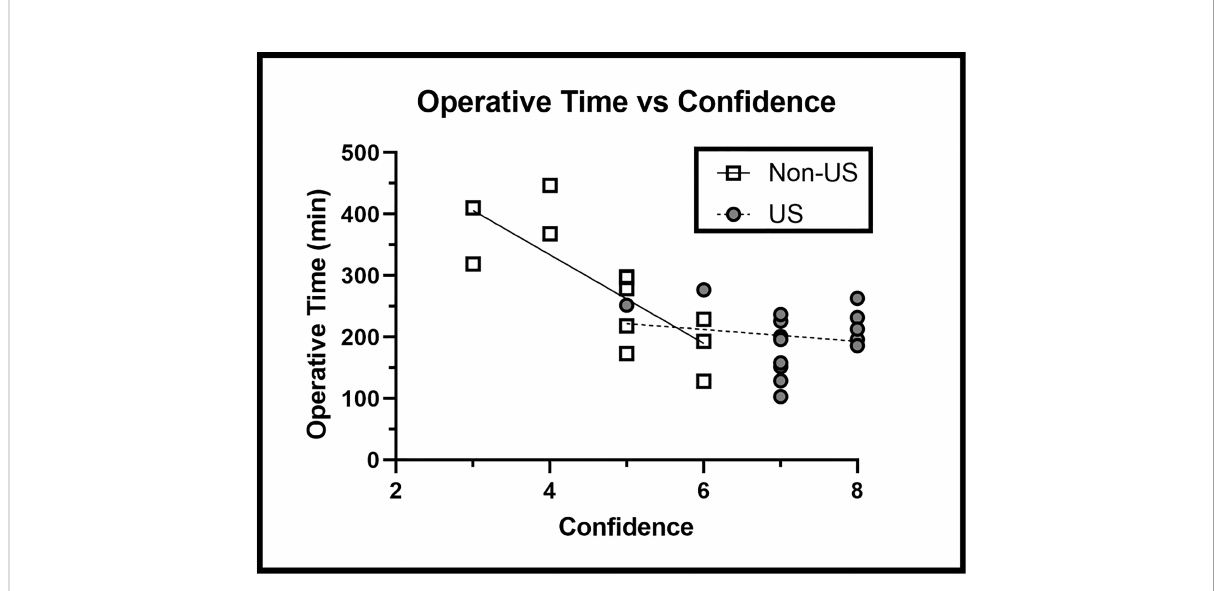
FIGURE 6 Operative Time versus Surgeon Con fi dence Findings: IOUS use prevented the increase in operative time associated with lower levels of surgeon con fi dence (p =